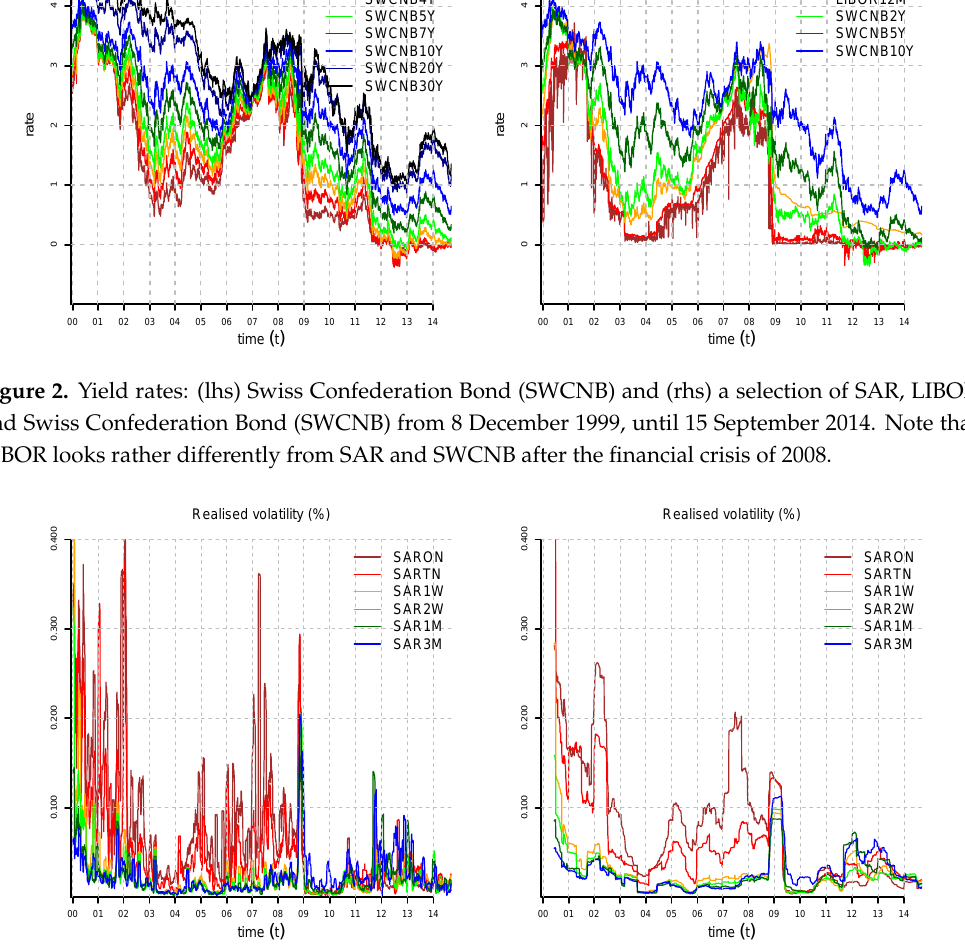
Figure 3. SAR realized volatility and K = 126